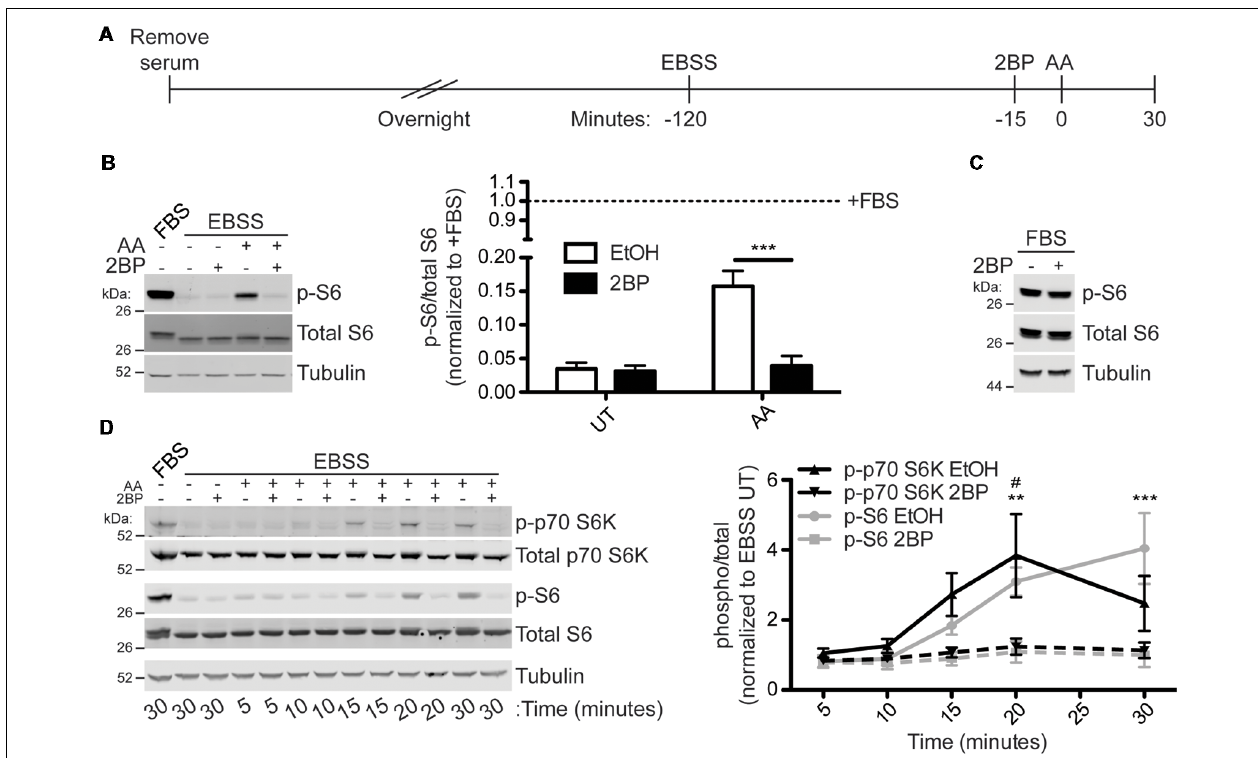
FIGURE 2 | Amino acid (AA) activation of mTOR Complex 1 (mTORC1) in HEK293T cells is palmitoylation dependent. (A) Scheme of the AA stimulation paradigm. HEK293T cells were incubated in serum-free media 16–20 h (overnight) prior to being placed in Earle’s Balanced Salt Solution (EBSS). One hour and 45 min